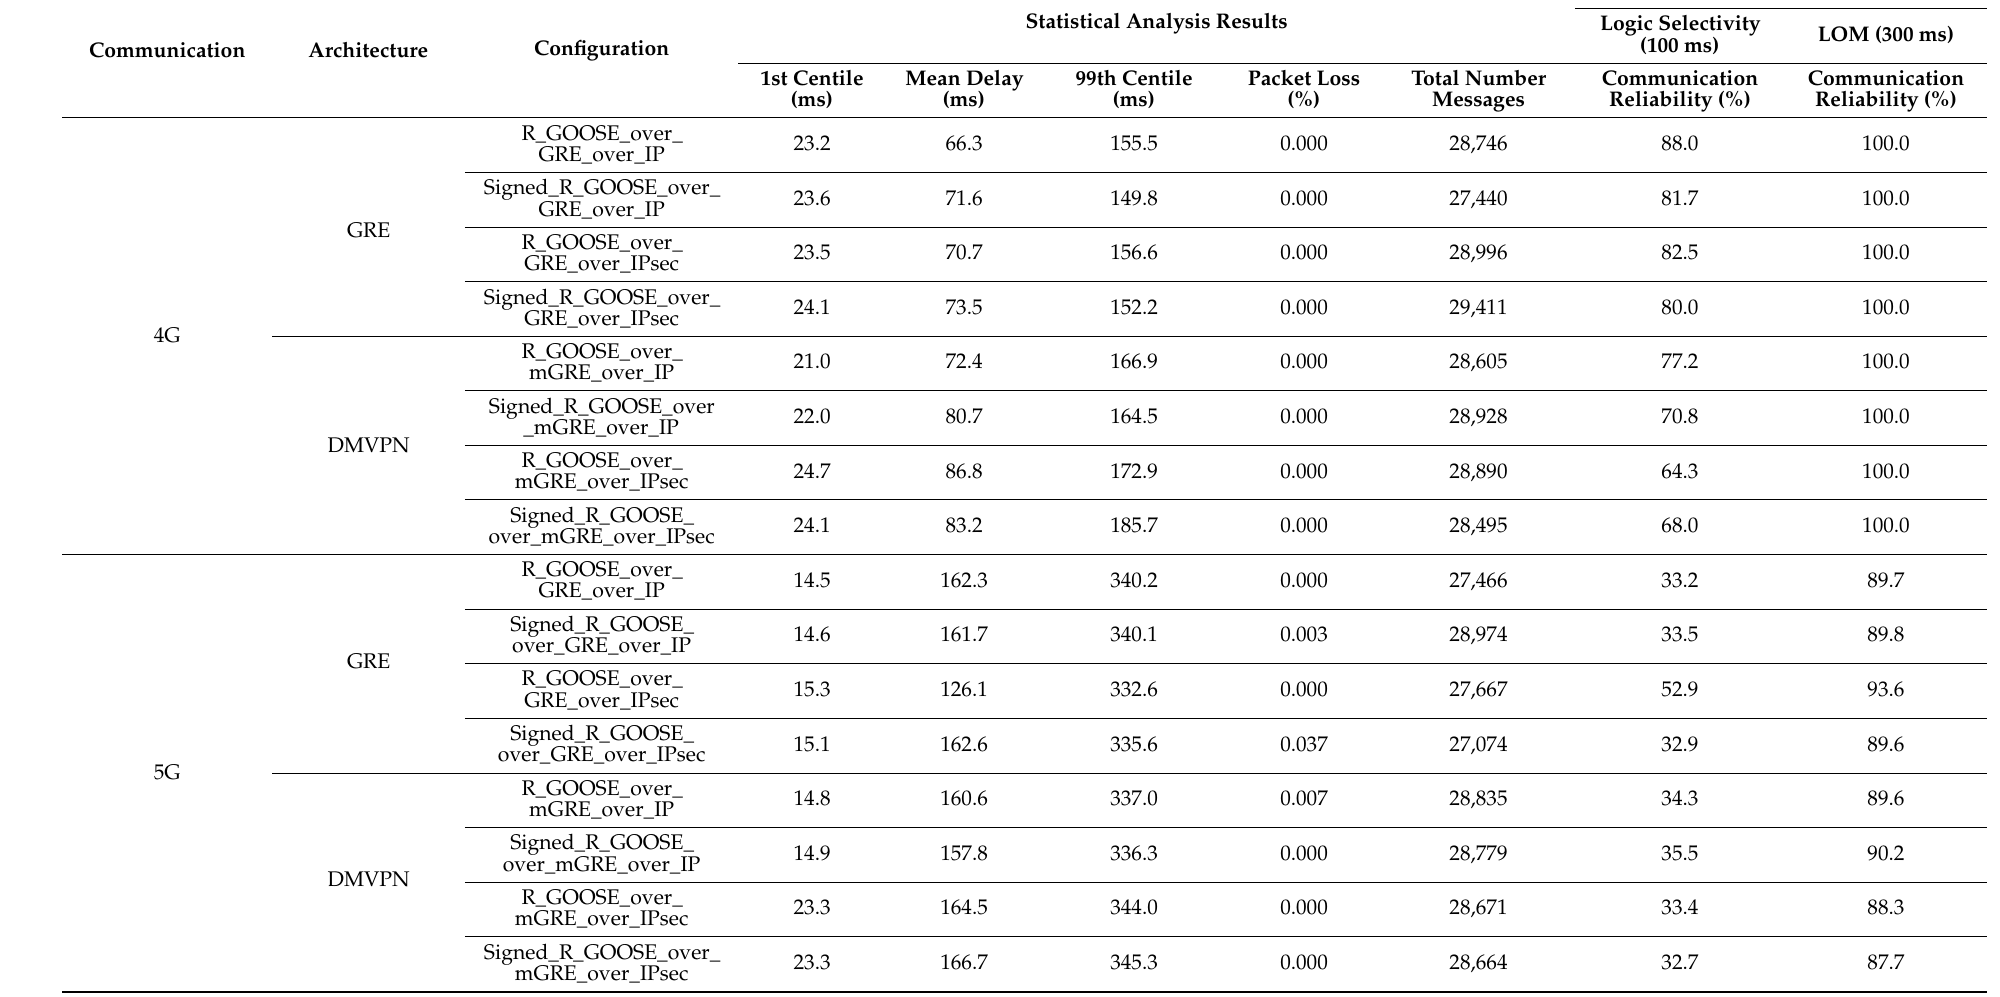
Table 6. Statistical analysis of the measurements